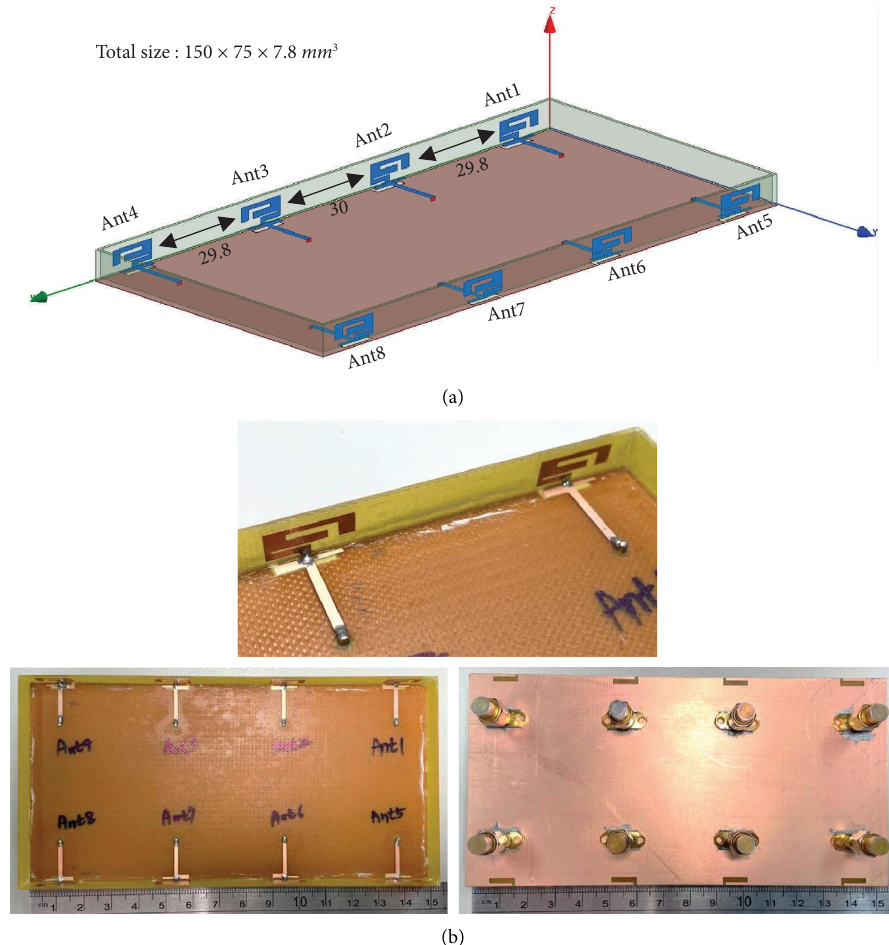
Figure 6: (a) Te confguration of the MIMO antenna array and (b) the photograph of the fabricated MIMO antenna